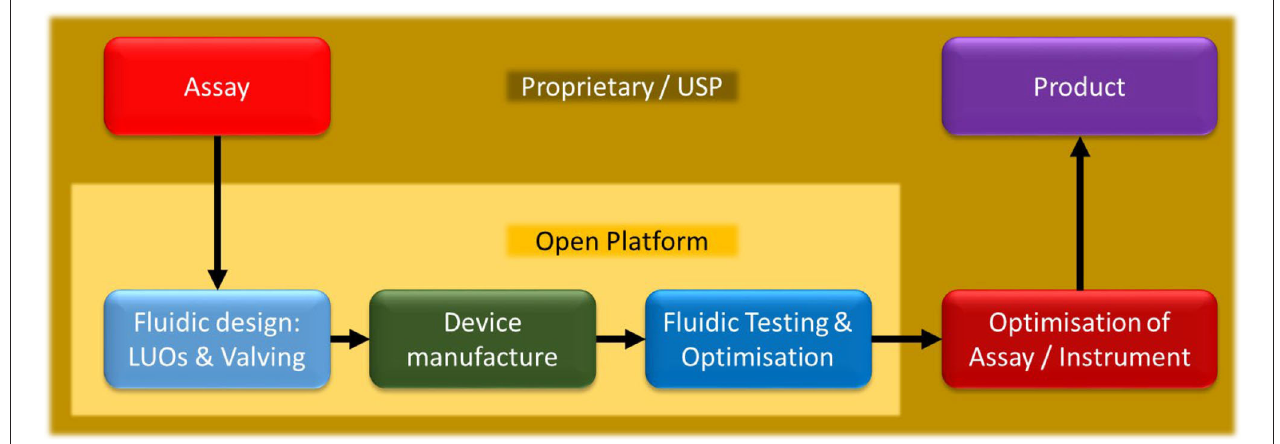
FIGURE 2 | Exemplary pipeline from idea to a unique microfluidic, e.g., “Lab-on-a-Disc” product. The proprietary part underpinning the Unique Selling Points (USPs) comprises of the original idea of an assay protocol, its reagents, or application including specific optimization cost, performance, productization, and marketing; the embedded, shared part comprises of a library of fluidic designs, testing, and manufacturing methods that are sourced from a common, multi-party RTD and supply chain, e.g., following foundry-type business models that are, for instance, well-proven in the electronics/MEMS (Ersland and Somisetty, 2012) 15 or photonics (Khan et al., 2019)